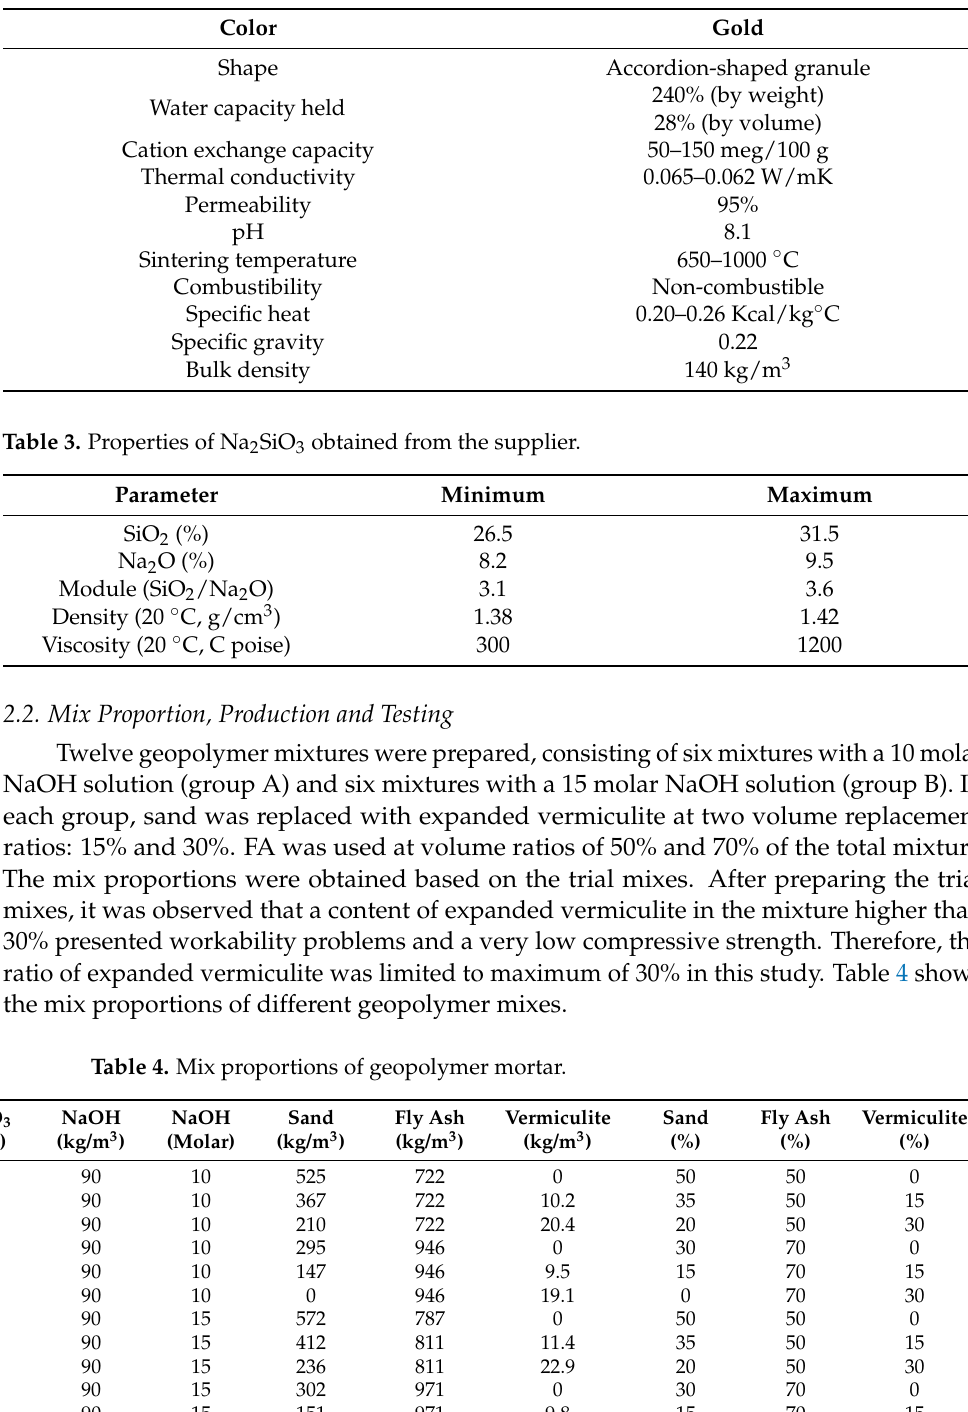
Table 2. Properties of the expanded vermiculite obtained from the supplier.